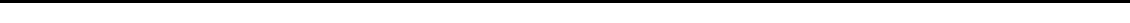
Fig. 3 VL30 activation requires cell-type-speci fi c TFs. a , b RT-qPCR of the VL30 U3 classes in RNA from Setdb1 cKO iMEFs ( a ) or ESCs (33#6, 3 ) ( b ), untreated or treated with 1 μ M all-trans retinoic acid (atRA), with or without 4OHT ( n = 3 biological replicates). For ESC data ( n = 2 biological replicates), we normalized each expression to VL30 U3 class I LTR expression of control iMEF. Error bars represent s.d. *0.005< P < 0.05, **0.0005 < P < 0.005, *** P < 0.0005, Student ’ s t -test. c Upper panel; the derepression induced by Setdb1 depletion in each VL30 U3 class I element (totally 71 elements) is shown. 22 loci on the right side have typical PBS-pro near the 3 ′ end of 5 ′ LTR. Selected loci for parallel alignment shown in d are denoted by H, M, and L symbols based on their derepression (H: high assigned to the locus where RPKM KO (RPKM of Setdb1 KO) is >100, M: mild assigned to 10 ≤ RPKM KO < 100, and L: low assigned to RPKM KO < 10, respectively). Lower panel: H3K9me3 ChIP-seq read counts on 5 ′ LTR at each VL30 U3 class I locus in Setdb1 cKO iMEFs (no treatment (WT: blue bar) and day 7 after treatment of 4OHT (KO: light blue bar)) are shown. d Alignment of U3 sequences of VL30 U3 class I. The red box indicates the consensus sequence of Elk family binding sites. The blue and green boxes indicate the consensus sequences of AP-1 and Ets, respectively. High, mild, and low indicate in Fig. 3c upper panel. Entire alignment of VL30 class I shown in Fig. 3c is in Supplementary Data 3. We de fi ned the copies for RPKM KO < 10 as silenced. e Inhibition of the MAPK pathway precludes the transcriptional activation of VL30 in Setdb1 KO iMEFs. RT-qPCR analysis of VL30 U3 class I. 4OHT treatment was applied for the fi rst 4 days and cells were harvested at day 6. The MEK inhibitor PD0325901 (PD; 1 µ M) was added for the last 24 h ( n = 2 biological replicates). Error bars represent s.d. *0.005 < P < 0.05, **0.0005< P < 0.005, Student ’ s t